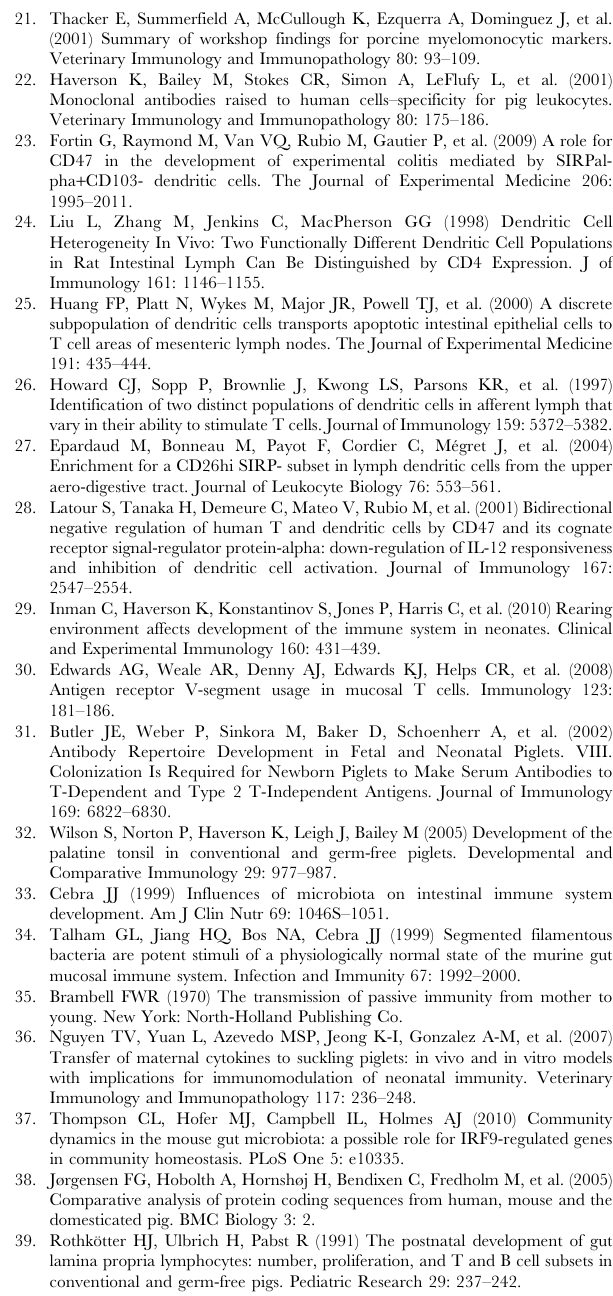
Table S1 TR b V group/subgroup specific primer sequences used for spectratyping. All PCR reactions had the same reverse primer, Universal C b . Twenty TR b V group, and 1 TR b V subgroup-specific forwards primers are listed. ‘S’ added after the V b group indicates designation according to the ImMunoGeneTic (IMGT) system